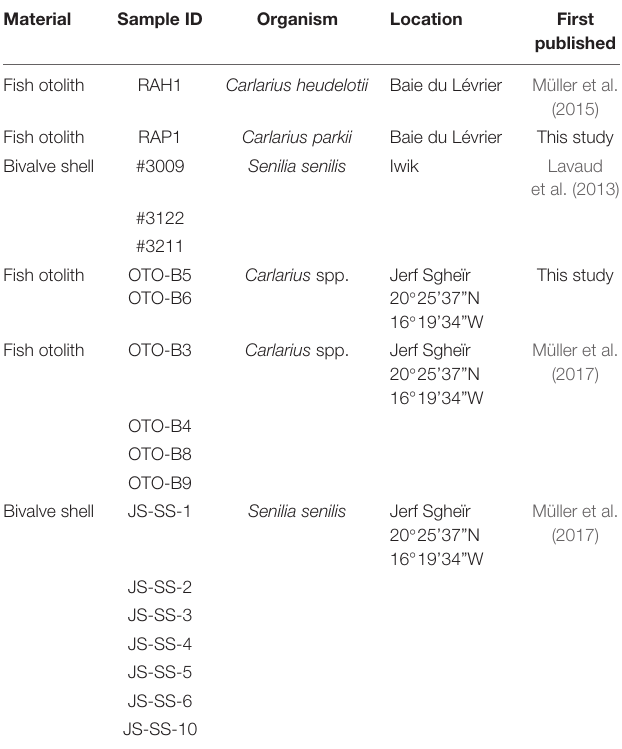
TABLE 1 | Mauritanian bivalve shells and fish otoliths used in this